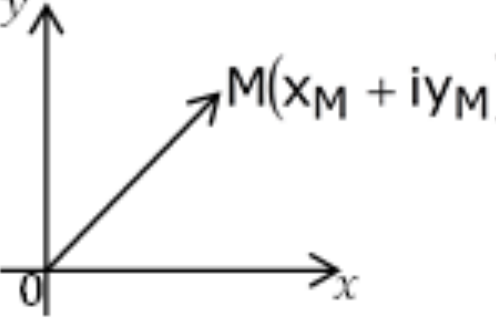
Figure 9. Treating a point M as a complex